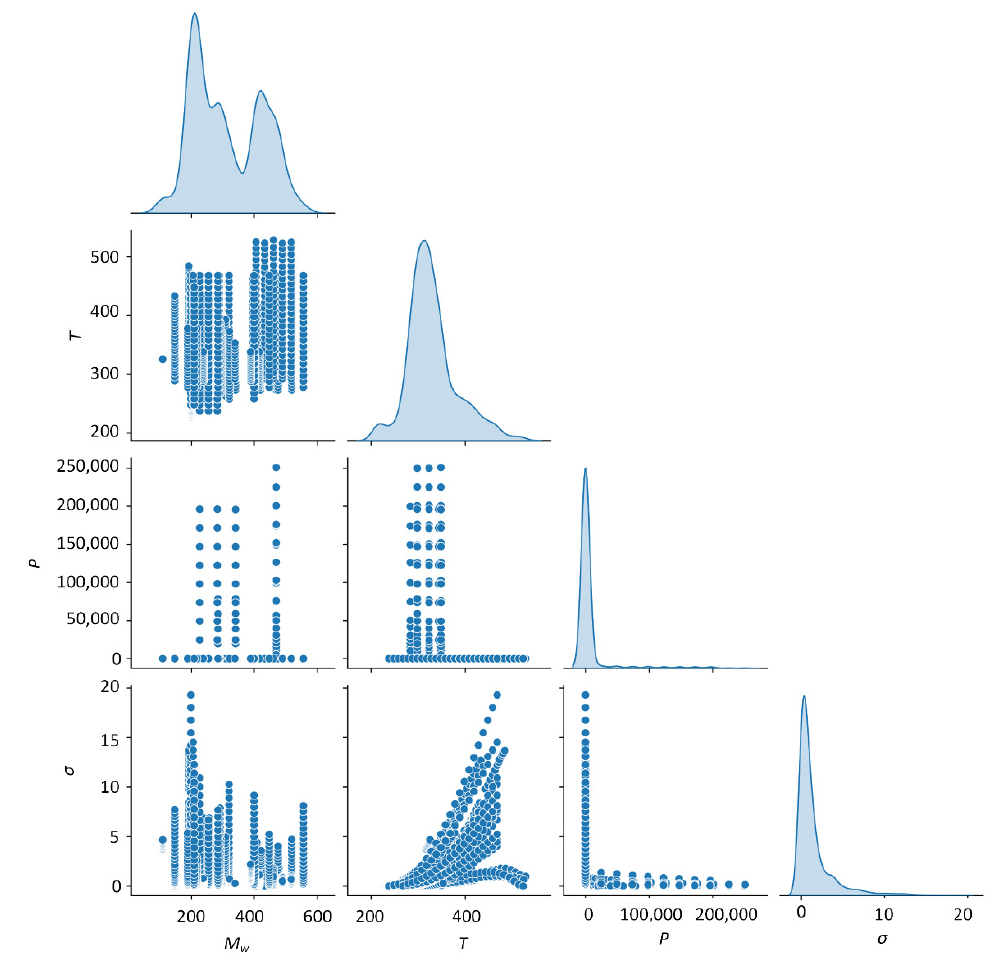
Figure 3. A pair plot diagram, showing input and output parameter distribution. The diagonal bar plots display the distribution of each parameter, while the remaining figures are scatter plots between all input pairs.